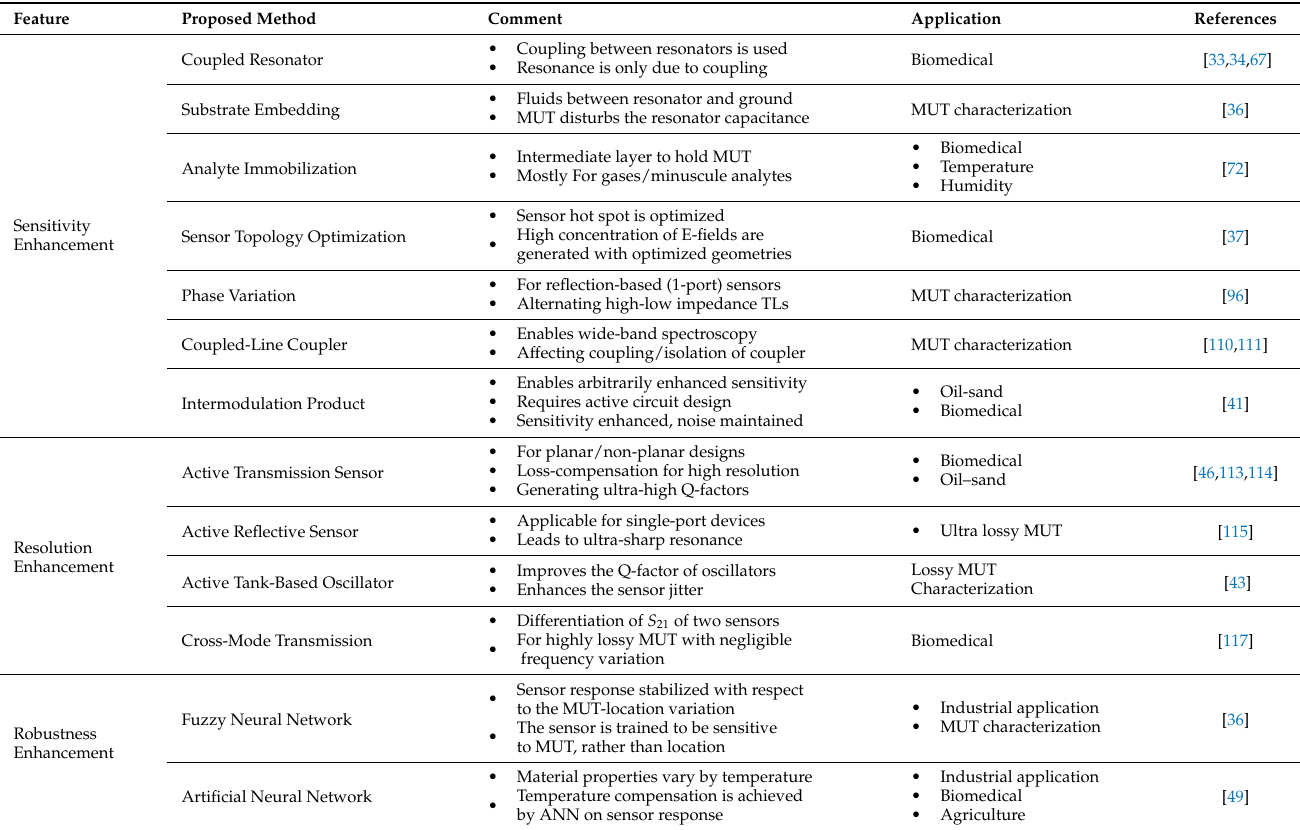
Table 4. Comparative analysis between various enhancing techniques for microwave planar